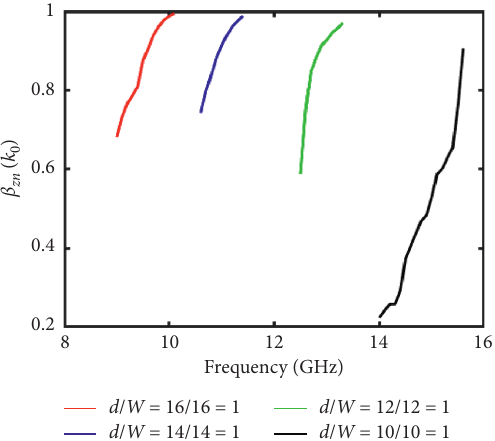
Figure 7: The normalized propagation constant of different pa- rameters when d / W � 1.